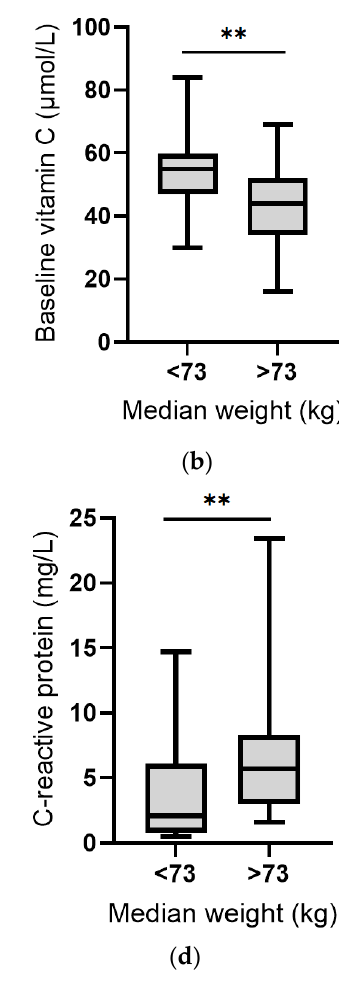
Figure 5. Distribution of plasma vitamin C concentrations of the study cohort at baseline ( n = 60).